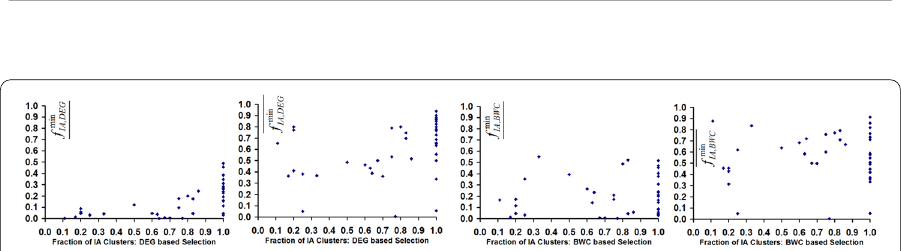
Fig. 12 Fraction of Louvain clusters with at least one initial adopter (IA) node versus the f min IA and f min IA values for the real-world